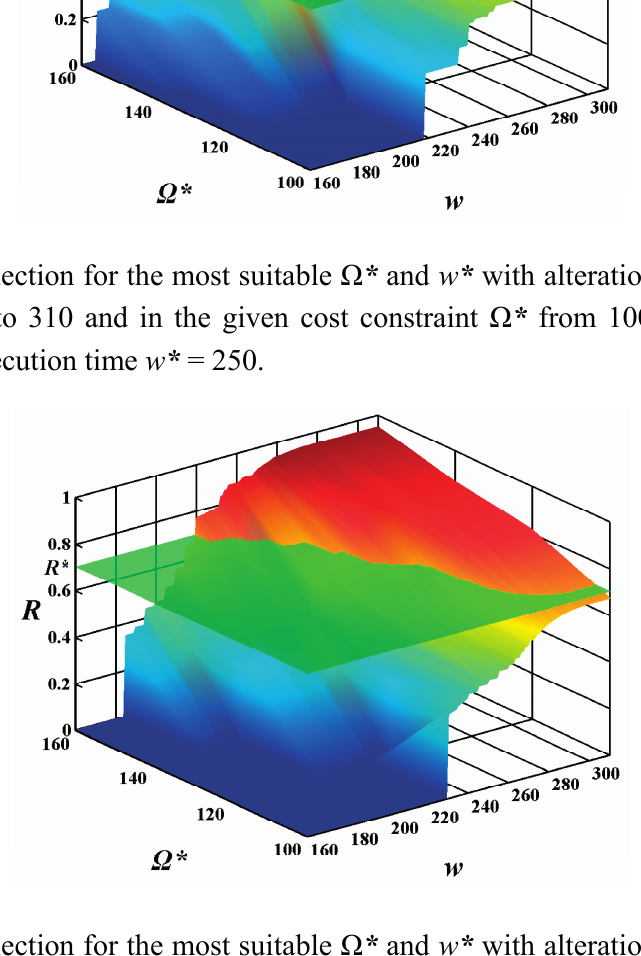
Figure 13. The selection for the most suitable Ω * and w * with alterations in the execution time w from 160 to 310 and in the given cost constraint Ω * from 100 to 160 under the given expected execution time w * =